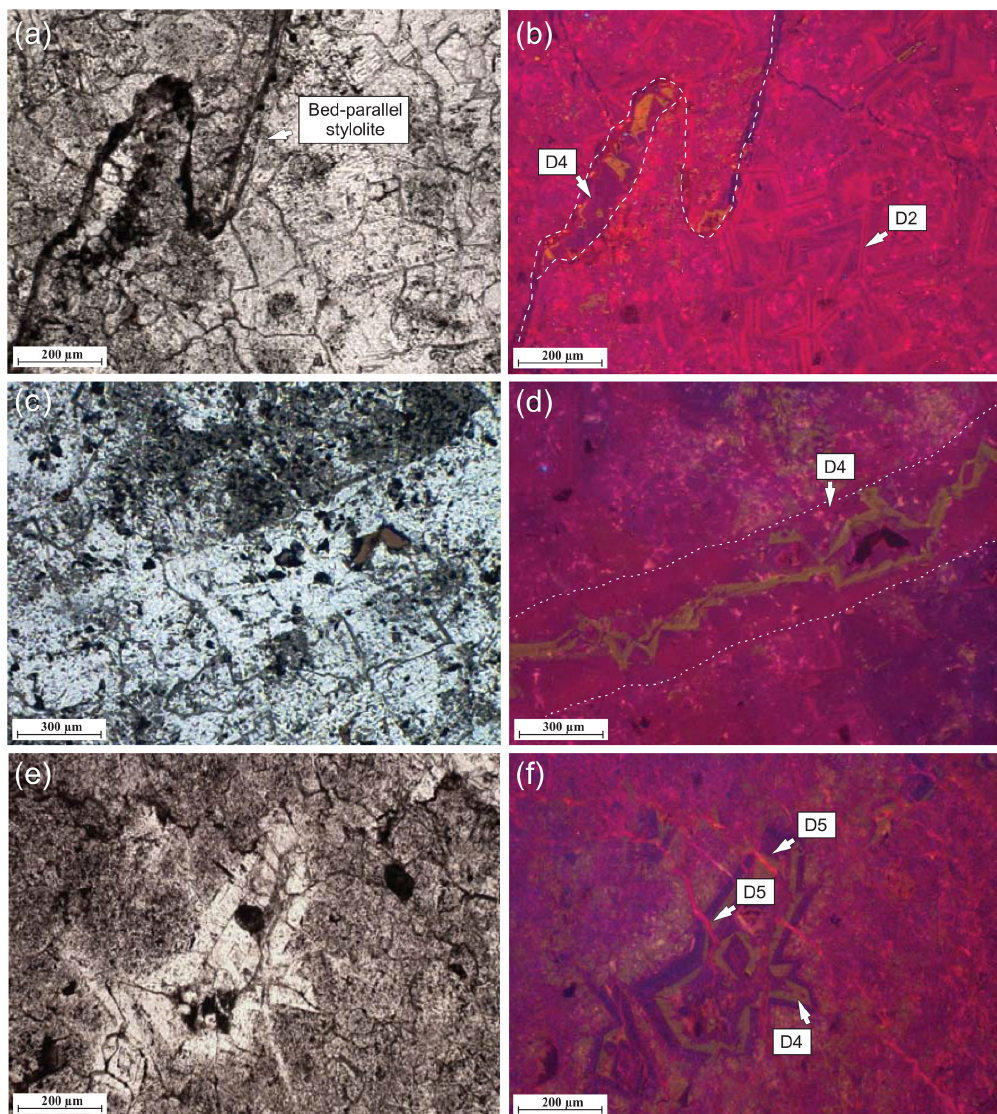
Figure 9. Photomicrographs showing transmitted light and corresponding cathodoluminescence images of D4 and D5 in relation to stylolites and fracturing. (a, b) D4, exploiting a bed-parallel stylolite that cross-cuts D1 and D2 sampled from dolomitized Calcare Massiccio Formation in field site d. (c, d) A subhorizontal fracture cemented by D4 sampled from dolomitized Corniola Formation in field site f. (e, f) D5 microveins (arrows) intersecting all the predating dolomite types in the footwall brecciated zone of the Montagna dei Fiori Fault, sampled from dolomitized Calcare Massiccio Formation in Castel Manfrino